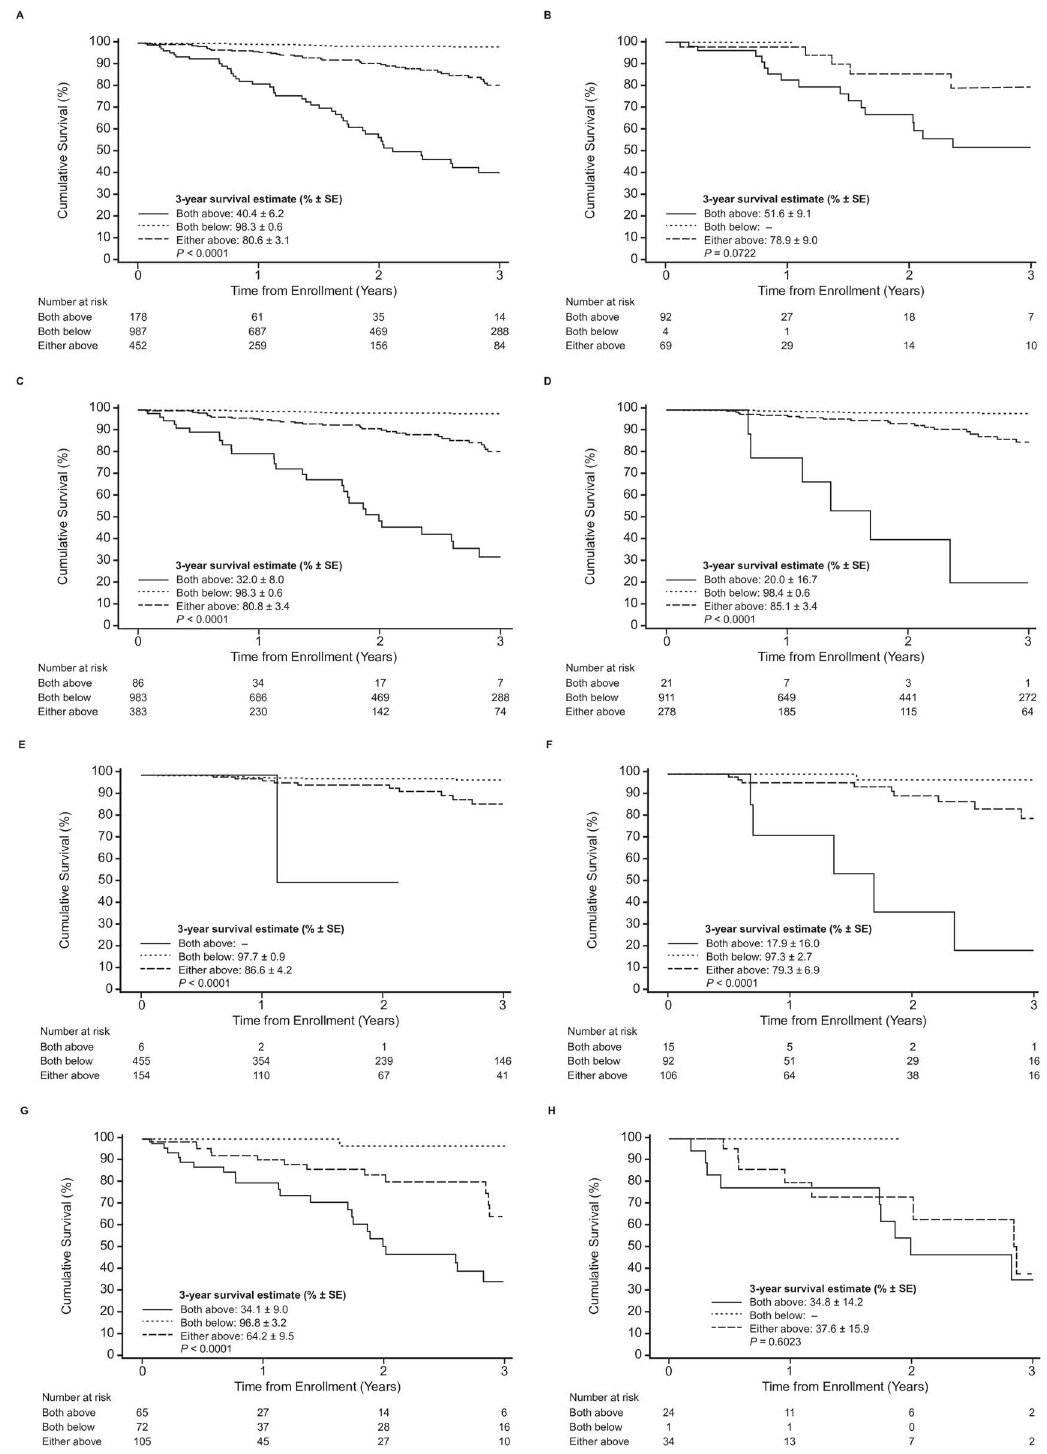
Fig 3. Association of survival and plasma levels of cardiac biomarkers in patients with ATTR using unadjusted log-rank test. Survivalstratified by combination of troponinT/I cut-off values as well as NT-proBNP/BNP quartilescut- off values (A) in the wholecohort; (B) in patients with wildtypeATTR; (C) in patients with mutant type ATTR; (D) in patients with Val30Met;(E) in patients with early onset of Val30Met; (F) in patients with late onset of Val30Met; (G) in patients with non-Val30Met; (H) in patients with Val122Ile. P -values are for the comparisonbetweenthe combination of